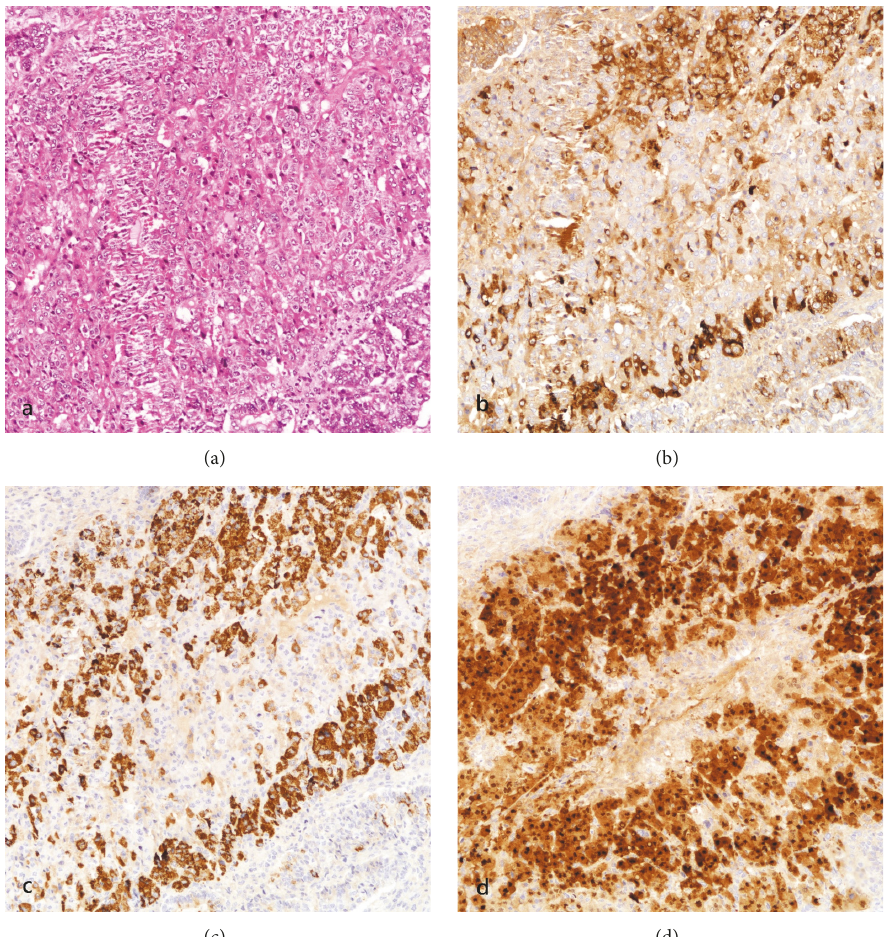
Figure 5: (a) Hepatoid adenocarcinomatous components in trabeculae, polygonal cells with eosinophilic cytoplasm (H&E); (b) AFP (Dako A0008, 1:2000, citrate at 98 ∘ C for 30 min); (c) HepPar-1 (Dako M7158, 1:900, EDTA at 98 ∘ C for 32 min); (d) arginase-1 (Cell Marque 380R-16, 1:400, EDTA at 98 ∘ C for 30